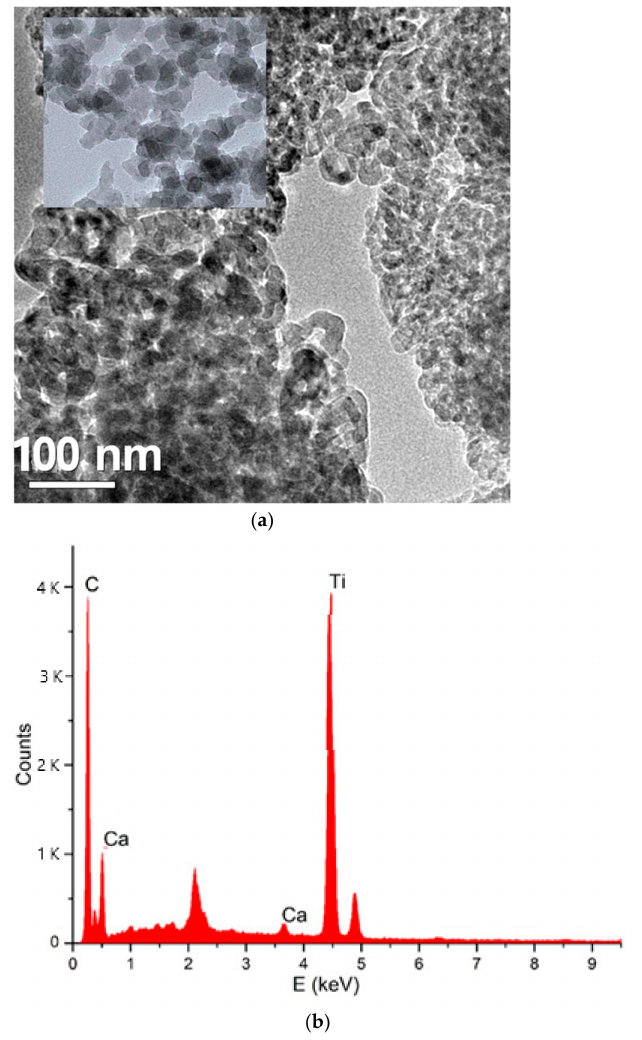
Figure 2. Examination of HTiO 2 particle anchoring on AC/SiO 2 surface; TEM ( a ) and EDx ( b ) analysis of HTiO 2 particle anchoring on the surface of AC/SiO 2